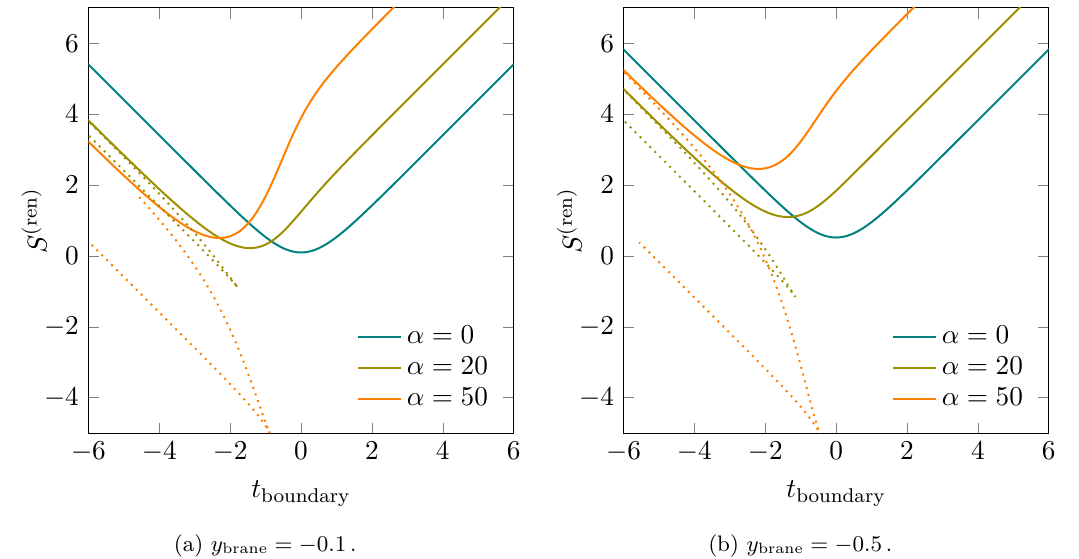
Figure 8 . Renormalized entropy S (ren) associated to extremal surfaces connecting to the brane as a function of the boundary time t . The entropies computed using extremal surfaces connecting to π τ brane < are displayed as dotted 2 −